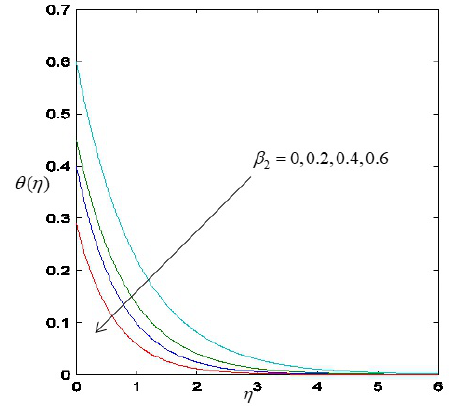
Fig. 5: Influence of f ′ ( η ) for various values of M